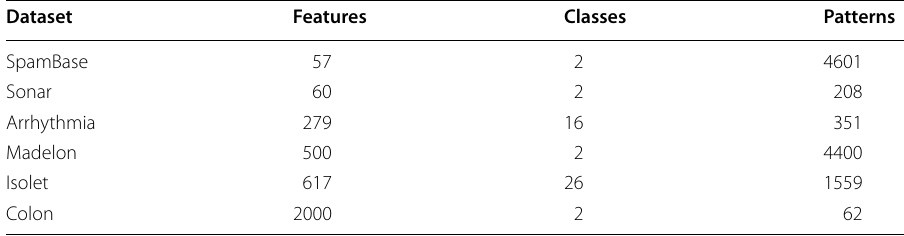
Table 1 Characteristics of the used medical datasets Dataset